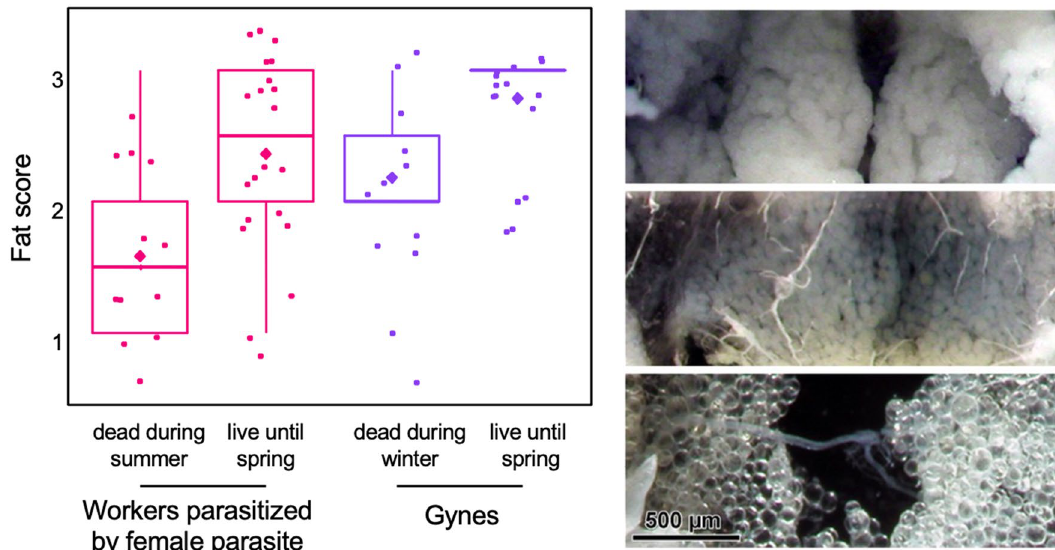
Figure 3. Fat scores of parasitized workers that died in the summer (n = 12) or survived until spring (n = 22) and non-parasitized gynes that died during the winter (October–February, n = 11) or survived until spring (n = 14). The boxplots show medians, quartiles, 5th and 95th percentiles and minimum and maximum values outside of the percentiles (color dots); diamonds represent means; points jittered to prevent overlap).